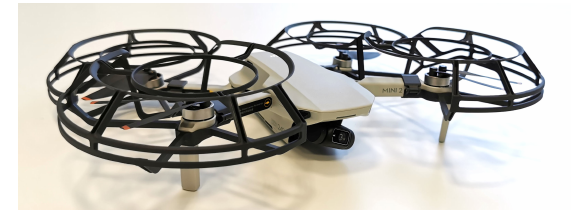
Figure 3. DJI Mini 2 drone.